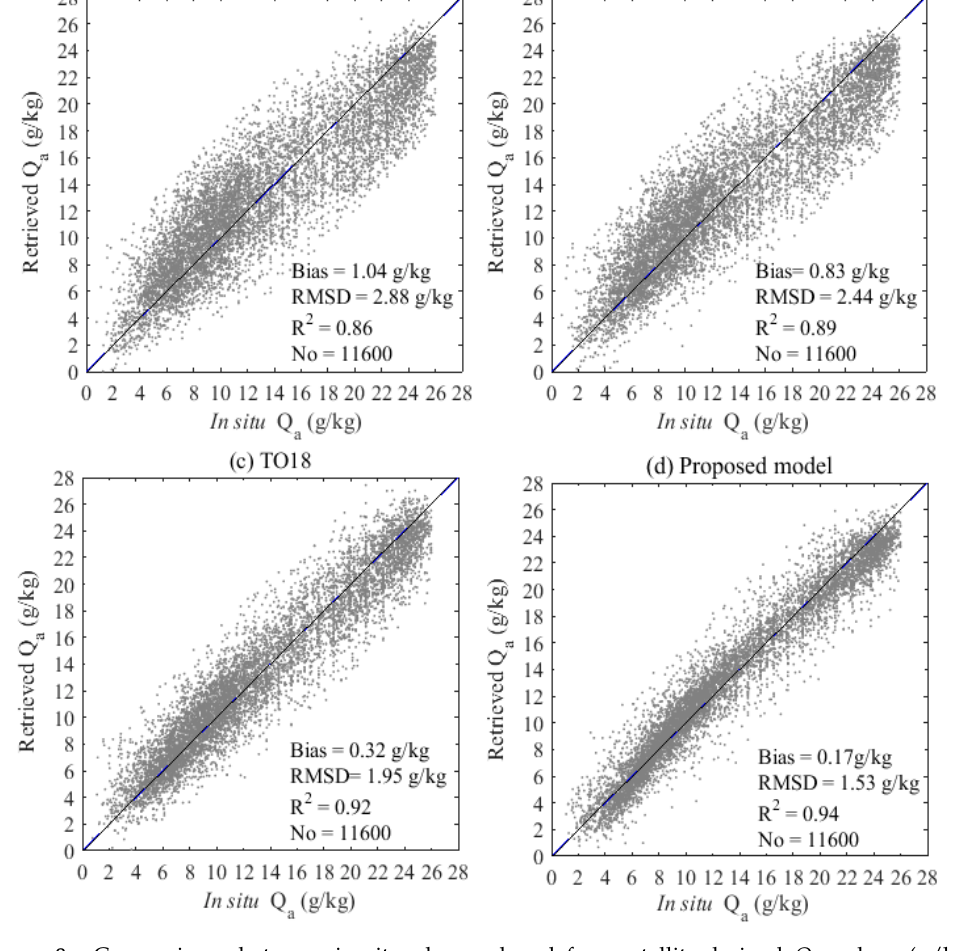
Figure 8. Comparisons between in situ observed and four satellite-derived Q a values (g/kg). ( a ) For SC95; ( b ) for IW12; ( c ) for TO18; and ( d ) for the proposed model.